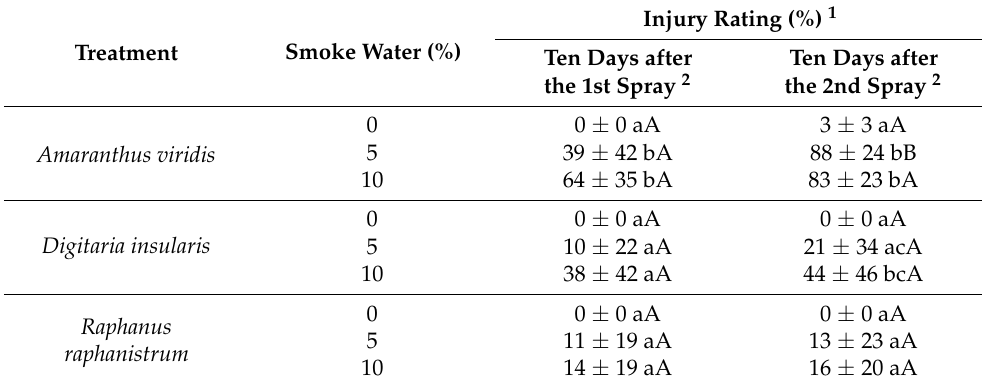
Table 4. Percent injury on weeds with two applications of smoke